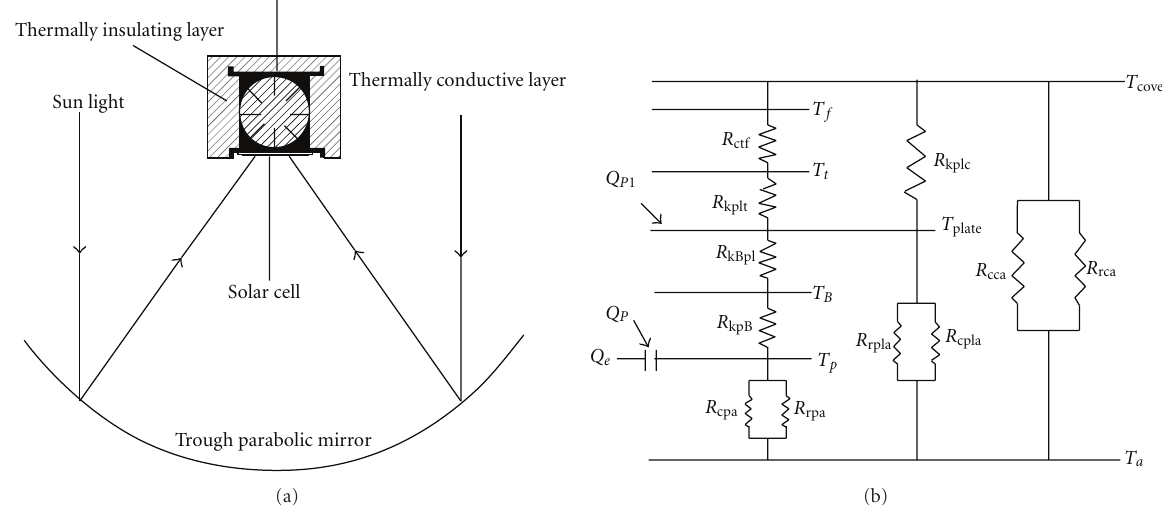
Figure 2: The thermal network describing the TCPV/T